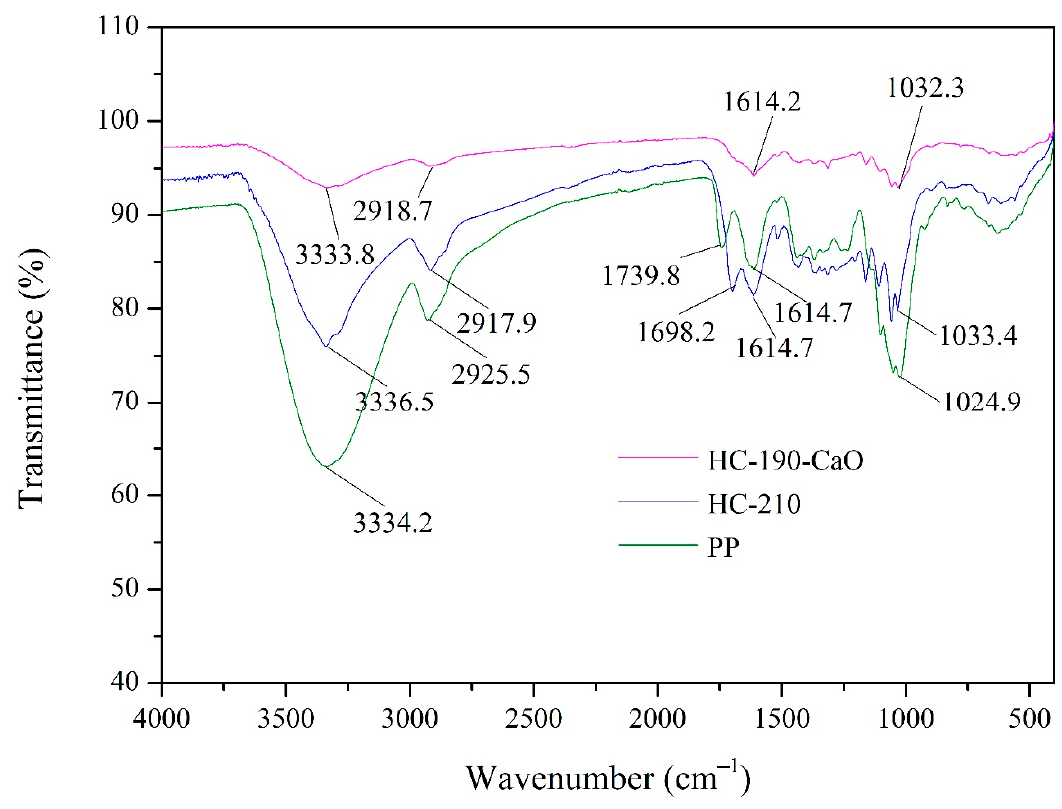
Figure 4. FTIR spectra of PP and HC products.